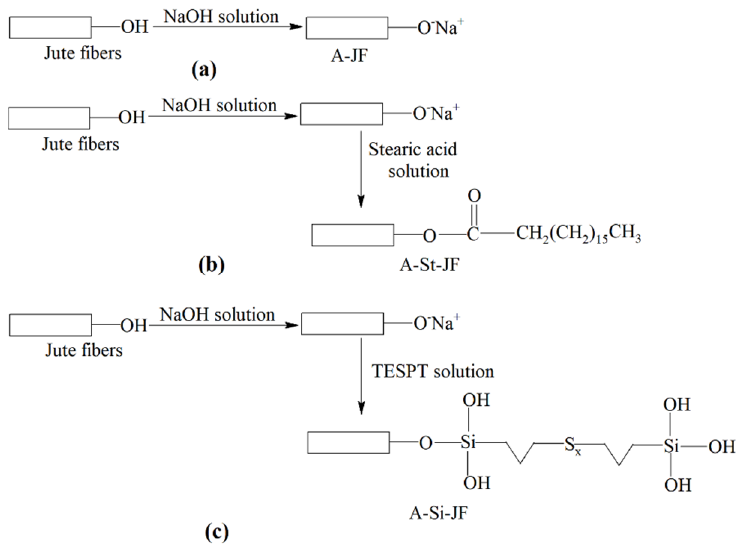
Figure 1. Mechanism of surface modification of jute fibers (JFs) by different chemical treatments, ( a ) alkali treatment, ( b ) combined alkali/stearic acid treatment, ( c ) combined alkali/silane treatment.